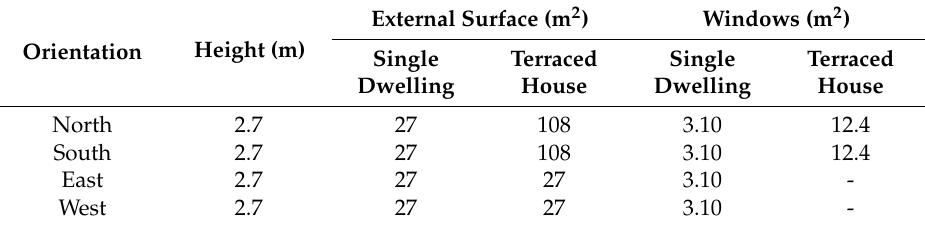
Table 4. Building geometry and orientation